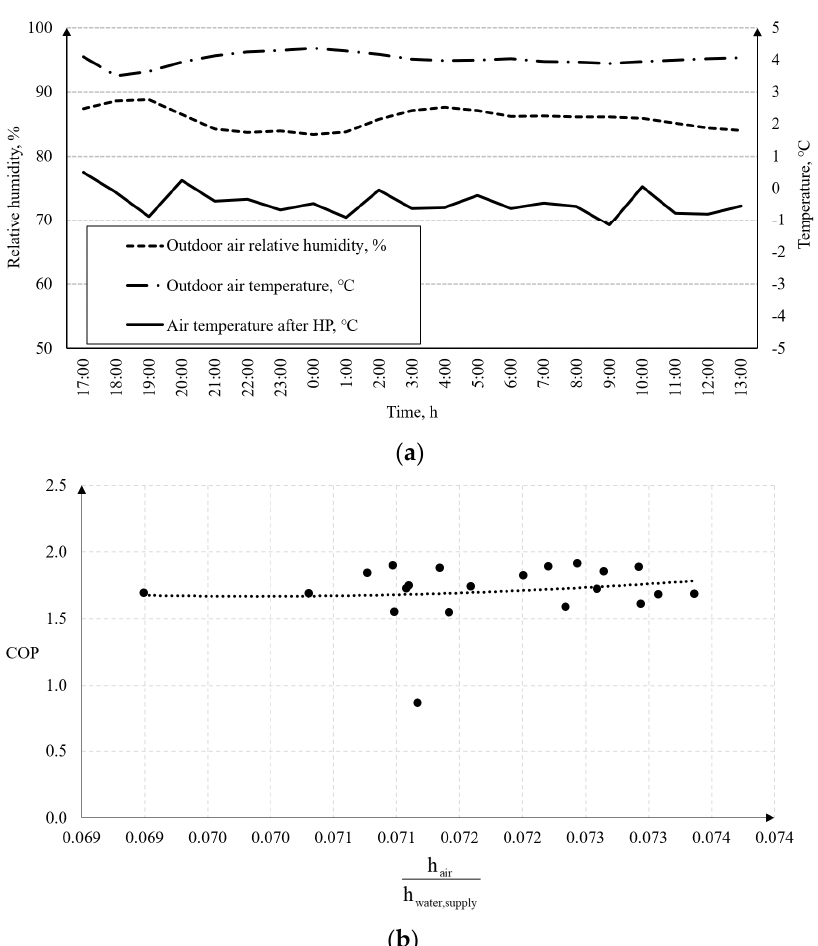
Figure 6. ( a ) Variation in ambient air parameters and temperature after ASHP evaporator; ( b ) variation in the COP depending on the ratio of enthalpies of ambient air and water supplied (11–12 November 2020).